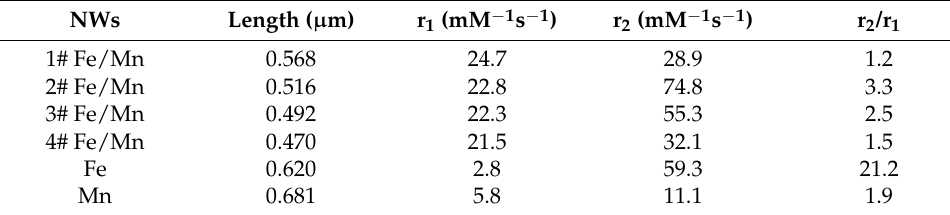
Figure 7. Relaxation properties of Fe/Mn@SiO 2 NWs: ( a ) The 1#~4# Fe/Mn@SiO 2 and Mn@SiO 2 NWs obtained a correlation line between 1/T 1 and Mn concentration in a 1.5T imager, and the slope of the fitting line was r 1 ; ( b ) The 1#~4# Fe/Mn@SiO 2 and Fe@SiO 2 NWs obtained a correlation line between 1/T 2 and Fe concentration in a 1.5T imager, and the slope of the fitting line was r 2 ; ( c ) MR T 1 weight diagram of 1#~4# Fe/Mn@SiO 2 NWs and Mn@SiO 2 NWs with different Mn concentrations ; ( d ) MR T 2 weight diagram of 1#~4# Fe/Mn@SiO 2 NWs and Fe@SiO 2 NWs with different Fe concentrations. Table 5. Relaxation of NWs.